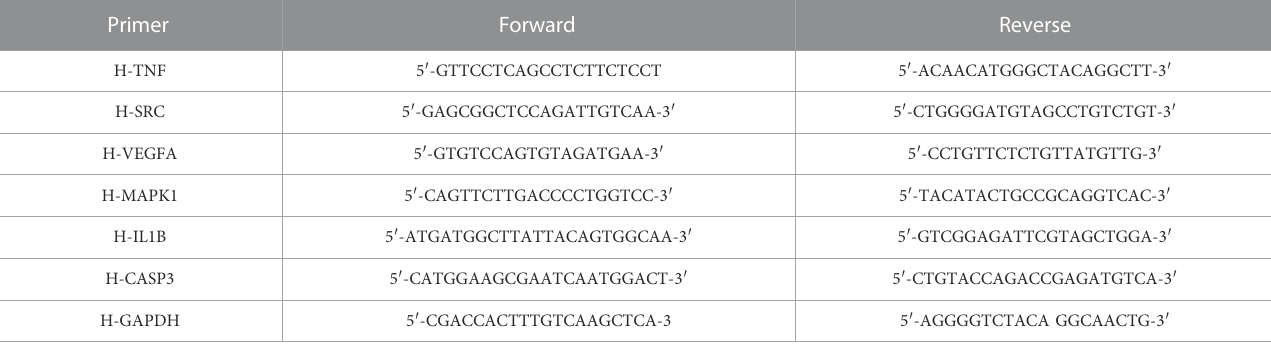
TABLE 1 Primer sequence of target